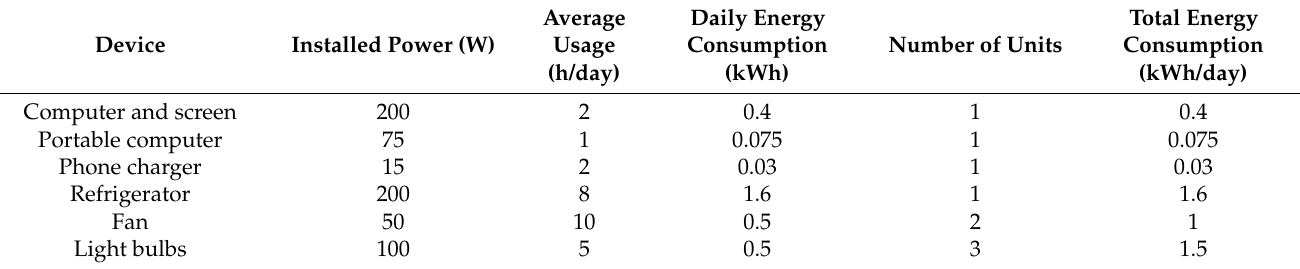
Table 2. The power consumption for the hybrid